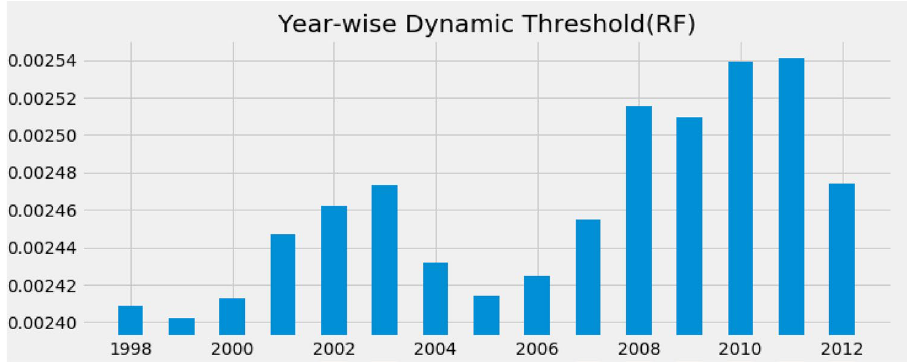
Figure 2. Fluctuation of dynamic threshold over different monitoring